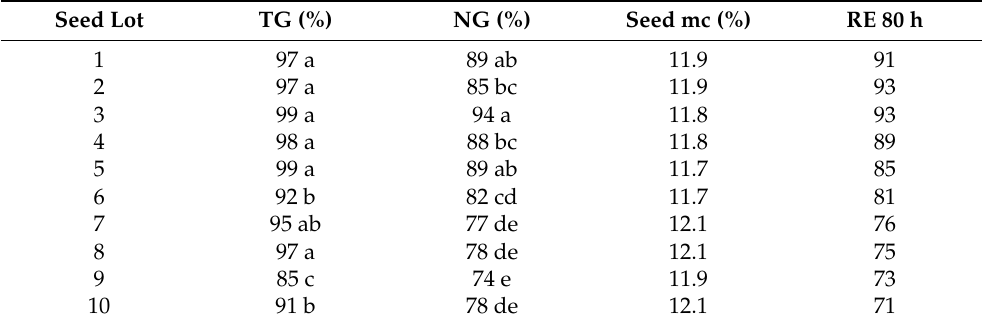
Table 1. Characteristics of the ten onion ( Allium cepa L.) seed lots used in the study: total germination (TG; %), normal germination (NG; %), seed moisture content (mc; %), and RE test count (%) at 80 h. Seed Lot TG (%) NG (%) Seed mc (%) RE 80 h 1 97 a 89 ab 11.9 91 2 97 a 85 bc 11.9 93 3 99 a 94 a 11.8 93 4 98 a 88 bc 11.8 5 99 a 89 ab 11.7 85 6 92 b 82 cd 11.7 81 7 95 ab 77 de 12.1 76 8 97 a 78 de 12.1 75 9 85 c 74 e 11.9 10 91 b 78 de 12.1 Mean values with a different letter or letters in the same column are statistically significant ( p <